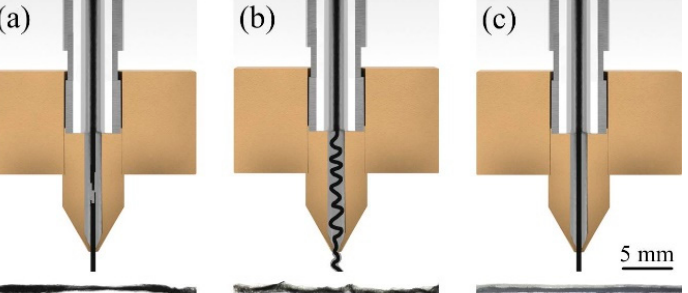
Figure 4. ( a ) The theoretical distribution state of continuous carbon fiber in nozzle melting chamber and the corresponding image of actual single channel when the the moving speed of the nozzle was greater than the wire feeding speed; ( b ) the moving speed of the nozzle was smaller than the wire feeding speed; ( c ) the moving speed of the nozzle was equal to the wire feeding speed.With equal values for the wire feed speed and nozzle moving speed, it is often necessary to increase the speed to improve the forming efficiency, but a faster wire feed and nozzle moving speed will also impact the single-pass forming